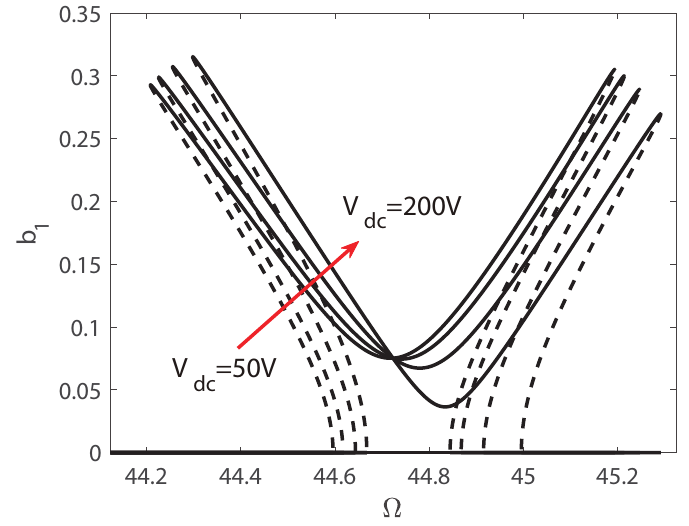
Figure 11. Frequency-response curves for different V dc